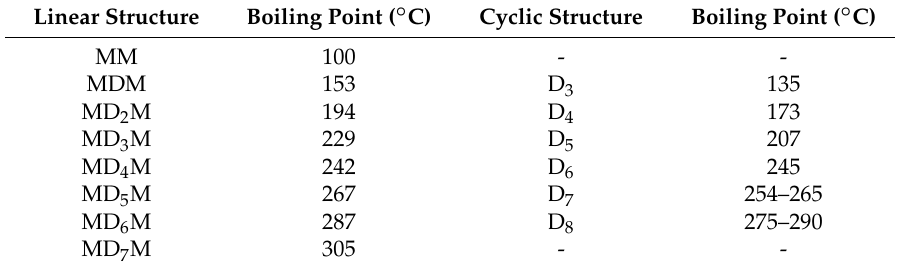
Table 2. Boiling points of linear and cyclic silicone oligomers. M: (CH 3 ) 3 SiO 1/2 –, and D: –(CH 3 ) 2 SiO– [8]. Linear